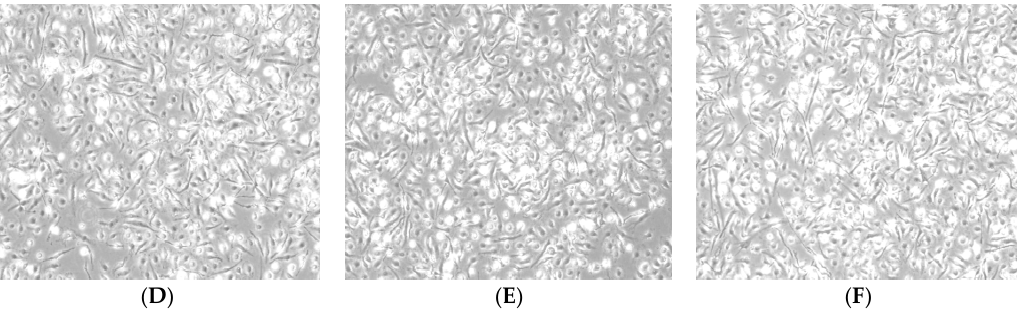
F igure 2 . Morphology of BMDMs induced by IL-4 and/or RAP. A . Control (normal BMDMs); B . M2 Figure 2. Morphology of BMDMs induced by IL-4 and / or RAP. ( A ) Control (normal BMDMs); ( B ) M2 macrophages (20 ng/mL of IL-4 induced BMDMs for 24 h); C . M2 macrophages treated with 30 ug/mL macrophages (20 ng / mL of IL-4 induced BMDMs for 24 h); ( C ) M2 macrophages treated with 30 µ g / mL of RAP; D . M2 macrophages treated with 100 ug/mL of RAP; E . M2 macrophages treated with 300 of RAP; ( D ) M2 macrophages treated with 100 µ g / mL of RAP; ( E ) M2 macrophages treated with 300 ug/mL of RAP; F . M2 macrophages treated with 1 ug/mL of LPS. µ g / mL of RAP; ( F ) M2 macrophages treated with 1 µ g / mL of LPS.